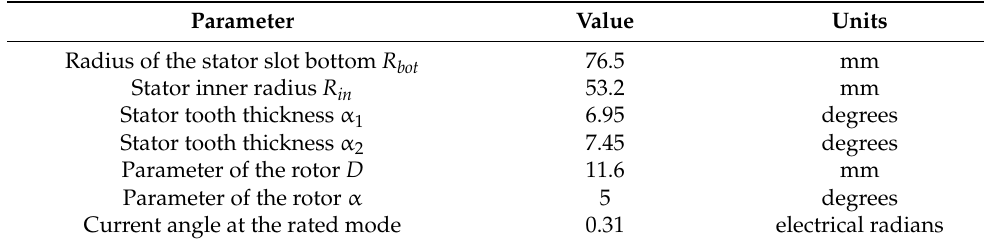
Table 9. Optimized values of the varied parameters of the IPMSM.